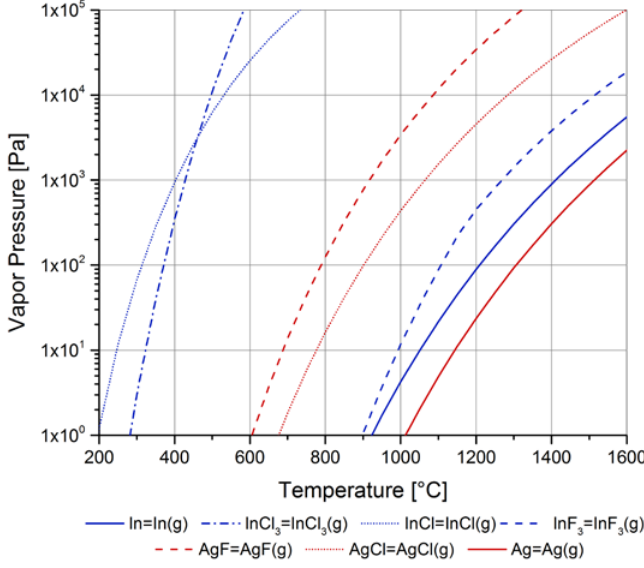
Figure 2. Vapor pressures for selected indium (blue lines) and silver compounds (red lines) as a function of temperature.